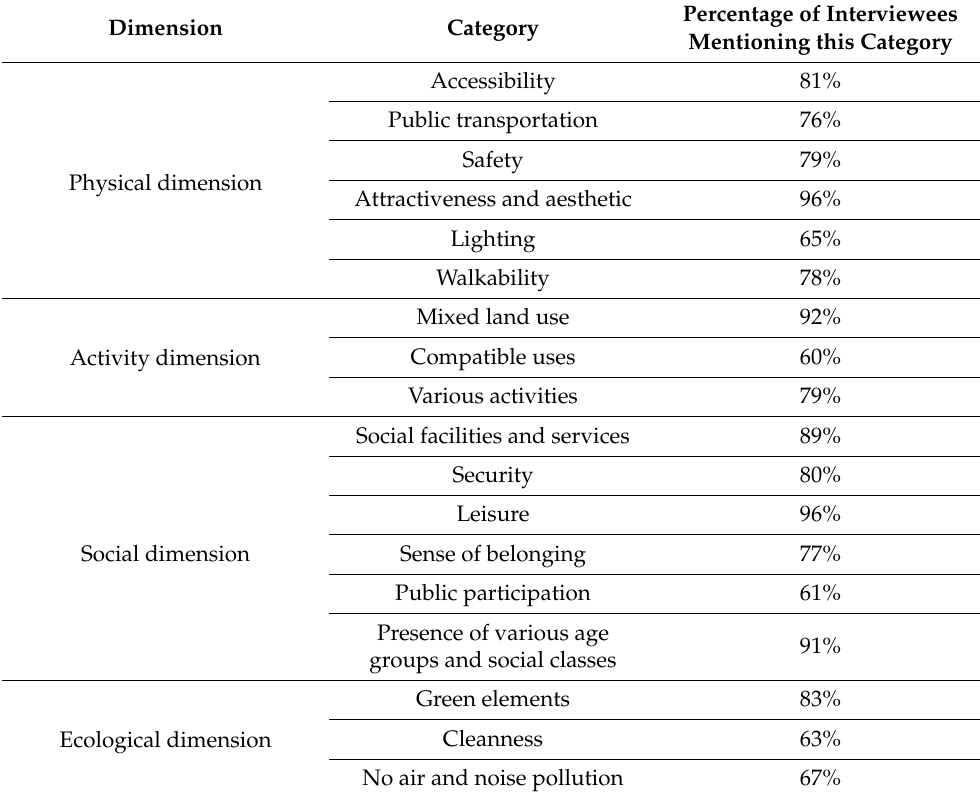
Table 5. Dimensions, categories, and scores of